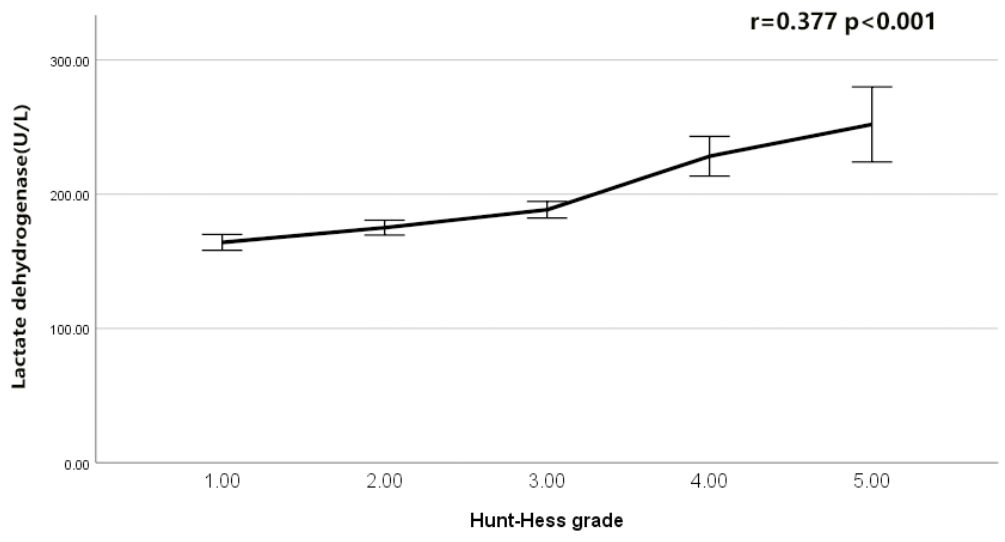
Figure 3. Correlation of LDH with Hunt−Hess grade after intracranial aneurysm rupture.